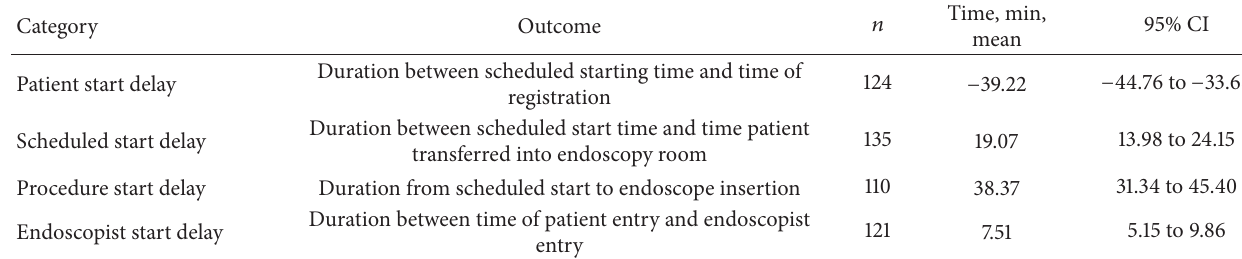
Table 3: Data regarding endoscopy workflow start time delays.